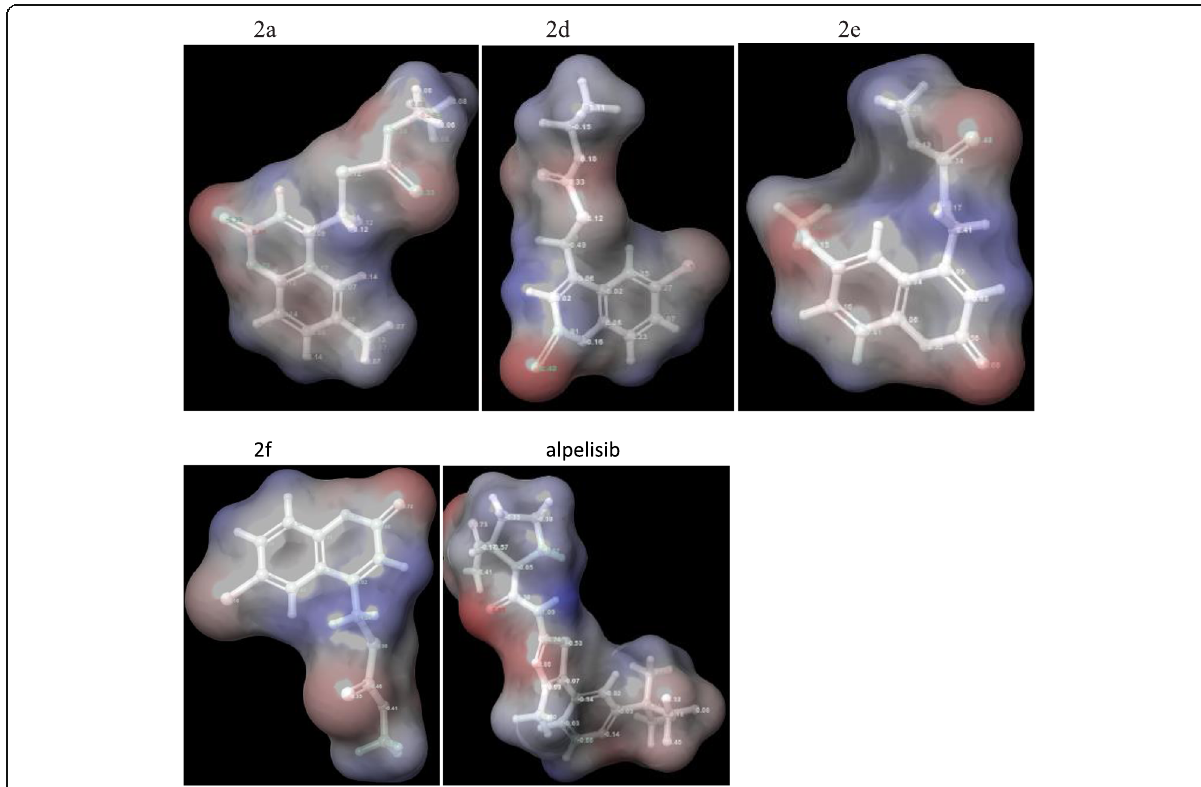
Fig. 1 Electrostatic potential value plotted on the surface of 2a, 2d, 2e, 2f, and alpelisib respectively using electro-static potential fitting charge (ESP) atomic charges by OPLS2005 force field (electropositive charge, blue; electronegative charge, red; neutral, white)